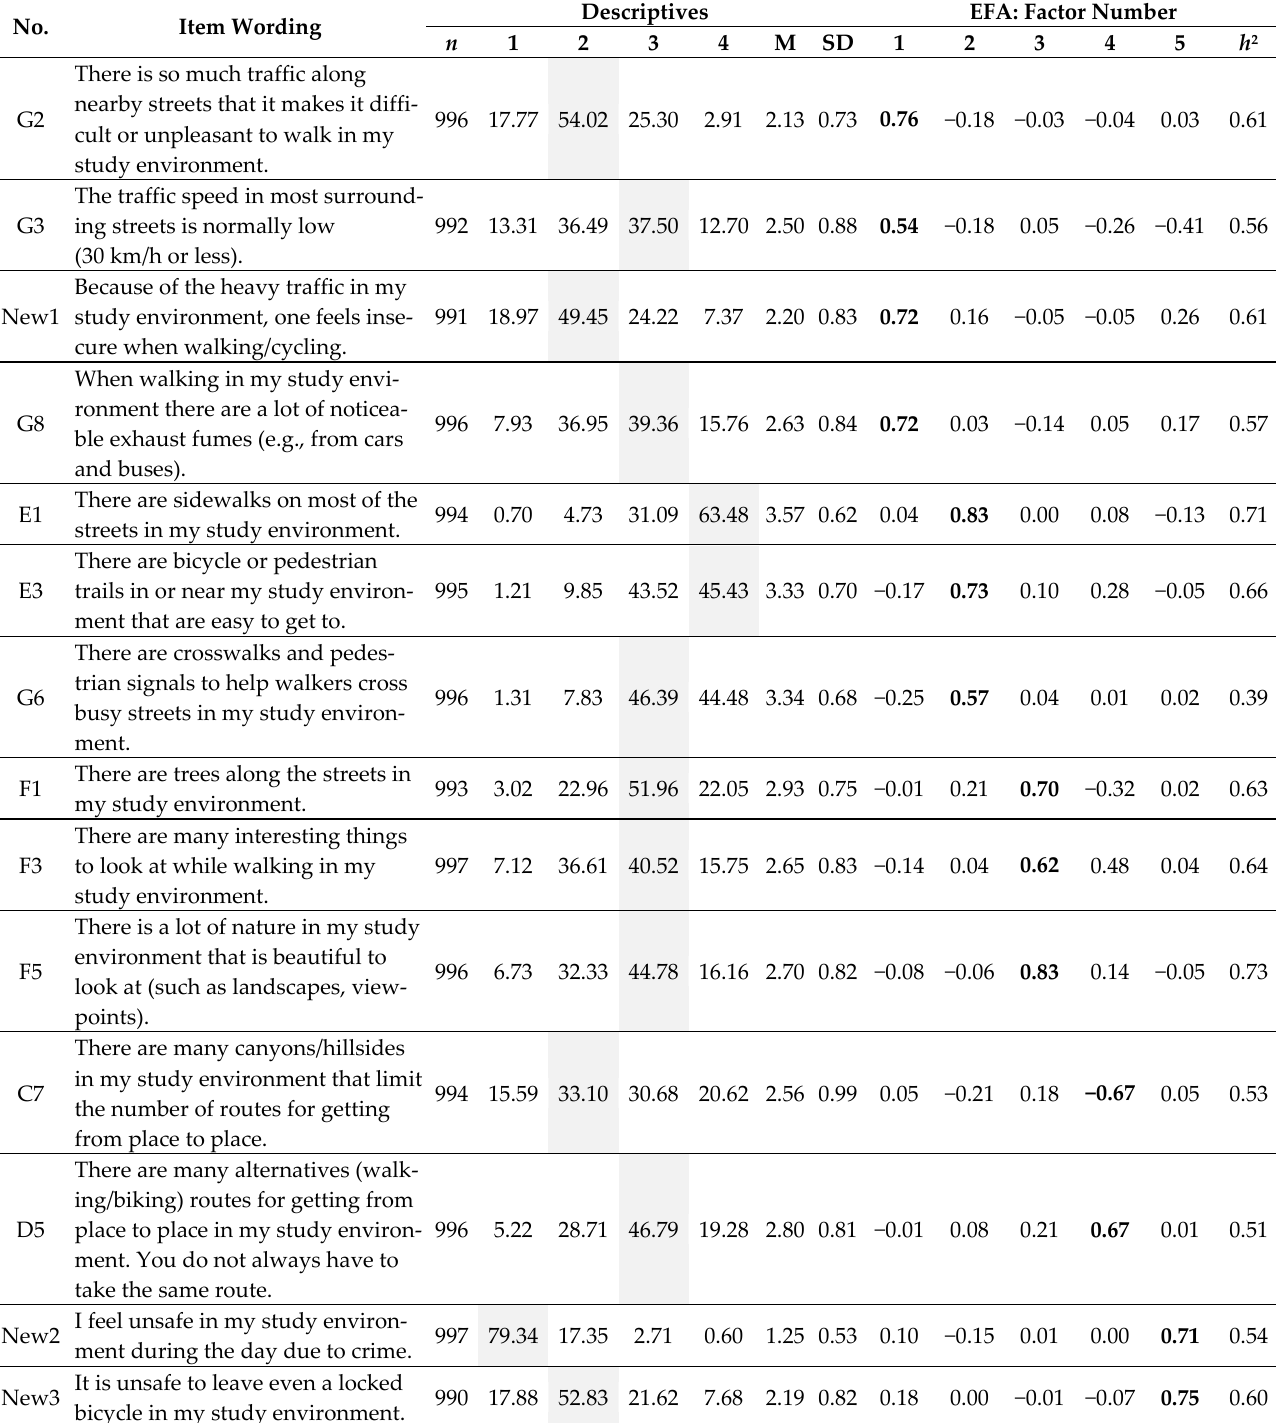
Table A4. Item’s descriptives (frequencies in %; 1 = totally disagree; 2 = more likely to disagree; 3 = more likely to agree; 4 = totally agree), factor loadings, and communalities ( h 2 ) of the explorative factor analysis (EFA) of perceived study environment.